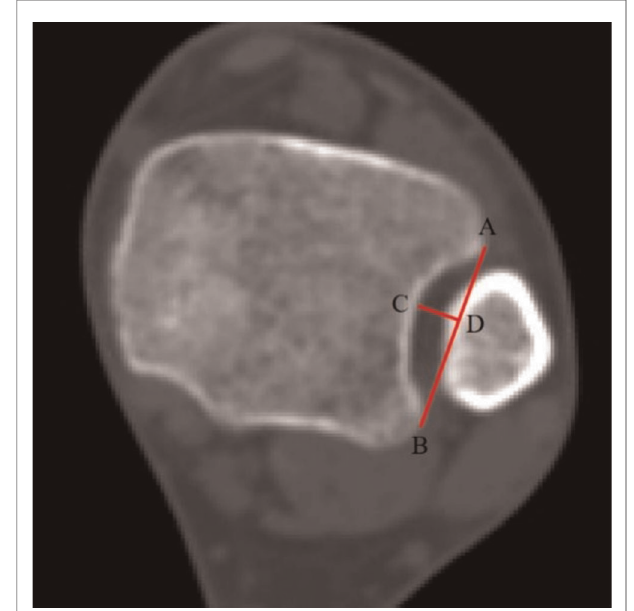
FIGURE 1 | This cross section is located at 1 cm proximal to the distal tibial plafond. Line AB is the tangent line to fi bular incisura, and point C is the deepest point of the fi bular incisura; through point C, a vertical line is made and intersects line AB at point D, and line CD is the depth of the fi bular